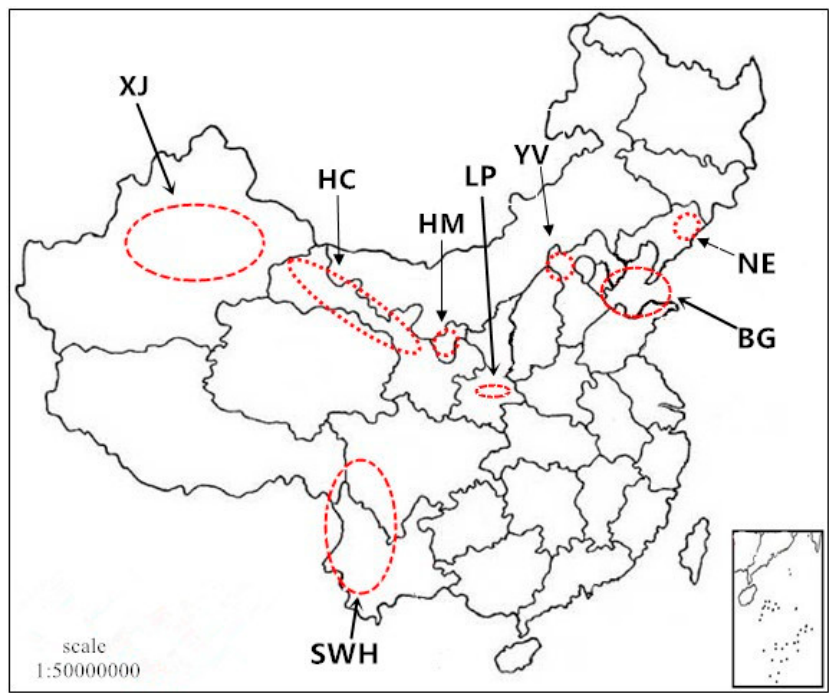
Figure 1. Geographical location of study areas of wine production in China (HM: Helan Mountain; XJ: Xinjiang; HC: Hexi Corridor; BG: Bohai Gulf; SWH: Southwest Highland; YV: Yanhuai Valley; NE: Northeast; LP: Loess Plateau).